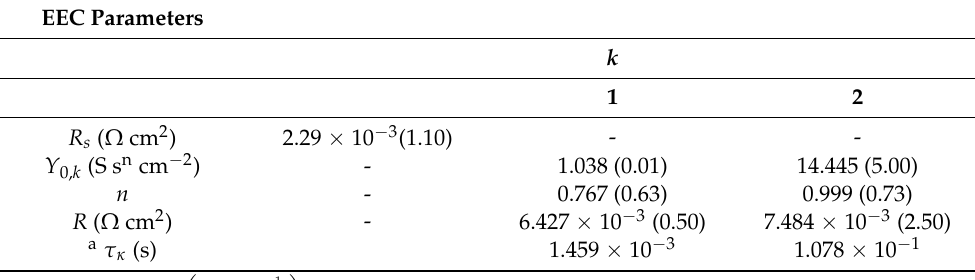
Table 6. Final and poor starting (in parentheses) EEC parameter values obtained by using EEC R(QR)(QR) and the automatic update limit strategy. EEC R(QR)(QR) was used only for experimental solid oxide fuel cells data fitting. The values are obtained by fitting the experimental data given in Figure